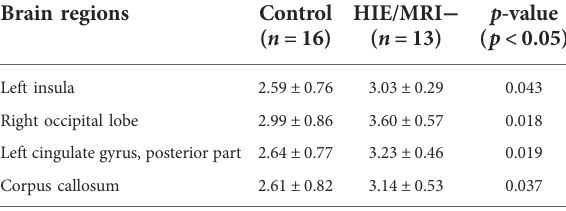
TABLE 3 Brain regions with signi fi cant APT signal intensity differences between the control and HIE/MRI − groups.